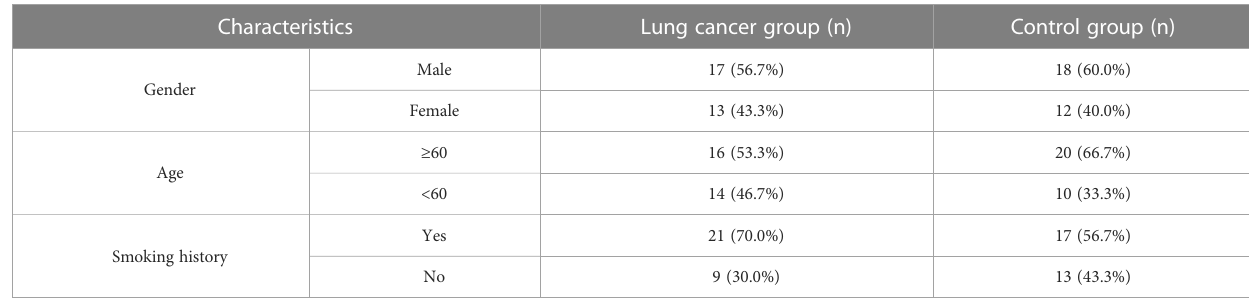
TABLE 1 General characteristics of the